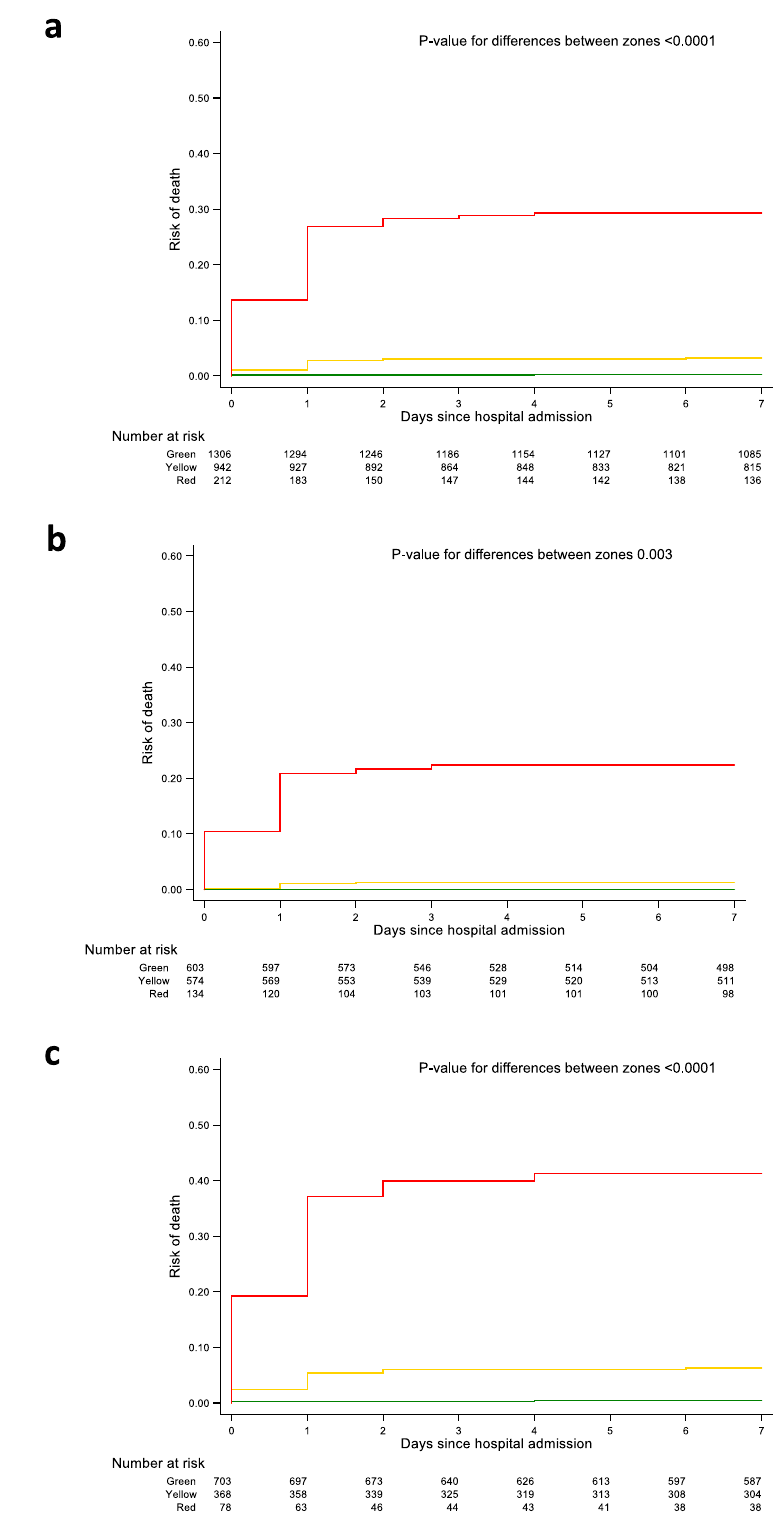
Fig. 3 Time-to-event analyses. Cumulative incidence of hospital death in the combined cohort ( a ), in the subgroup of children with P. falciparum malaria ( b ) and without malaria ( c ), strati fi ed into the “ green ” , “ yellow ” , “ red ” sTREM-1 zones. sTREM-1 cut-off values were generated using a LR − of 0.10 (<239 pg/mL) and LR + of 10 ( ≥ 629 pg/mL) derived in the derivation and validation cohorts combined corresponding to the mortality risk zones. Time-to- event curves were plotted based on Kaplan – Meier estimates. Wald test was used to calculate P -values for differences between zones.